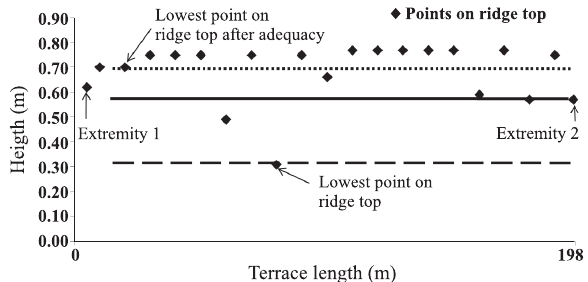
figure 4. Profile of the ridge height of terrace 1.